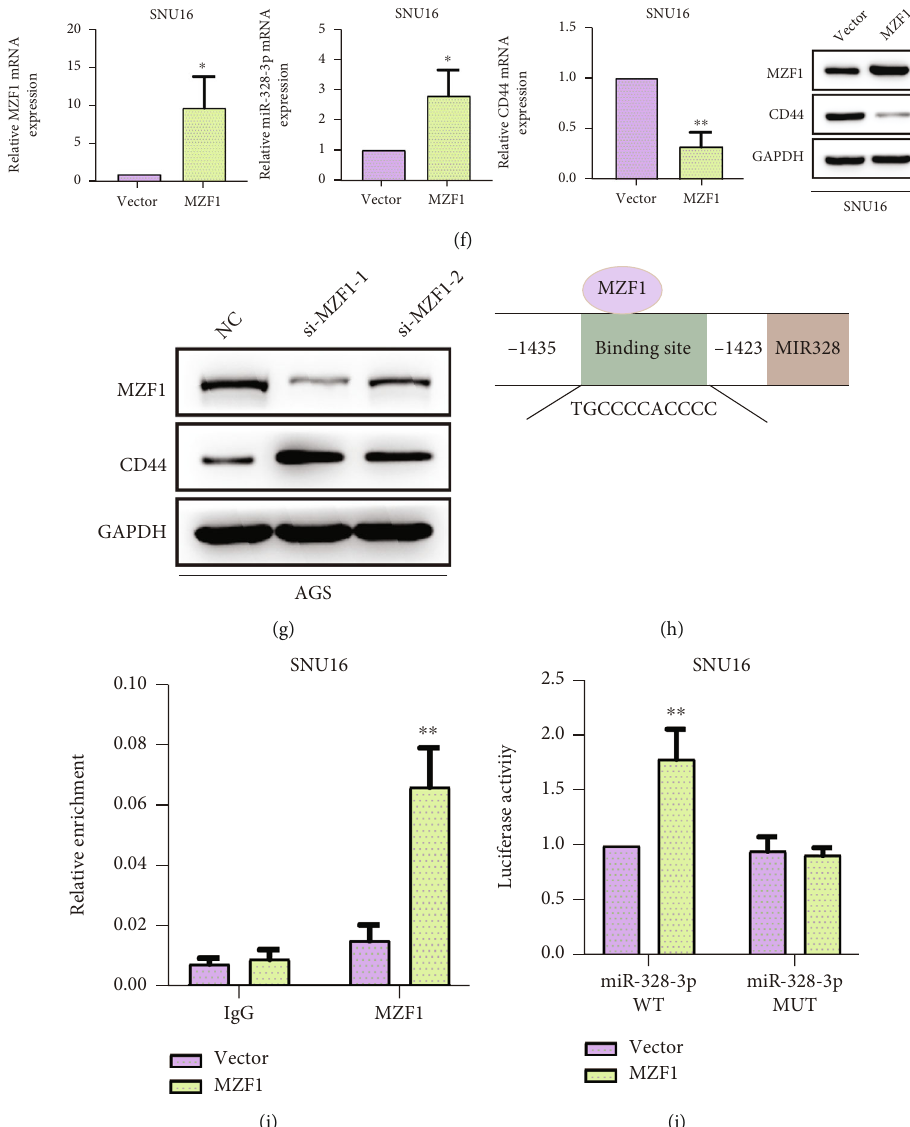
Figure 5: MZF1 activated the transcription of miR-328-3p. (a) PuTmiR and TransmiR databases were used to predict the transcription factor of miR-328-3p. MZF1, RREB1, BACH1, and STAT1 were four common transcription factors. (b) The expression levels of indicated four transcription factors in STAD tissues were analyzed. (c) The analysis of GC dataset in Oncomine database revealed MZF1 expression levels in STAD tissues. (d) qRT-PCR detection of MZF1 expression in STAD cells. (e, f) qRT-PCR assay was utilized to detect the expression levels of MZF1, miR-328-3p, and CD44 in (e) transfected AGS and (f) SNU16 cells. (g) Western blot assay was employed to detect the expression levels of MZF1 and CD44. (h) The TransmiR database was used to predict the binding sites of MZF1 in pre- miR-328-3p promoter regions. (i, j) The interaction between MZF1 and miR-328-3p was con fi rmed by (i) ChIP and (j) dual-luciferase reporter assays. All experiments were performed in triplicate. ∗ P < 0 : 05 , ∗∗ P < 0 : 01 , and ∗∗∗ P < 0 : 001